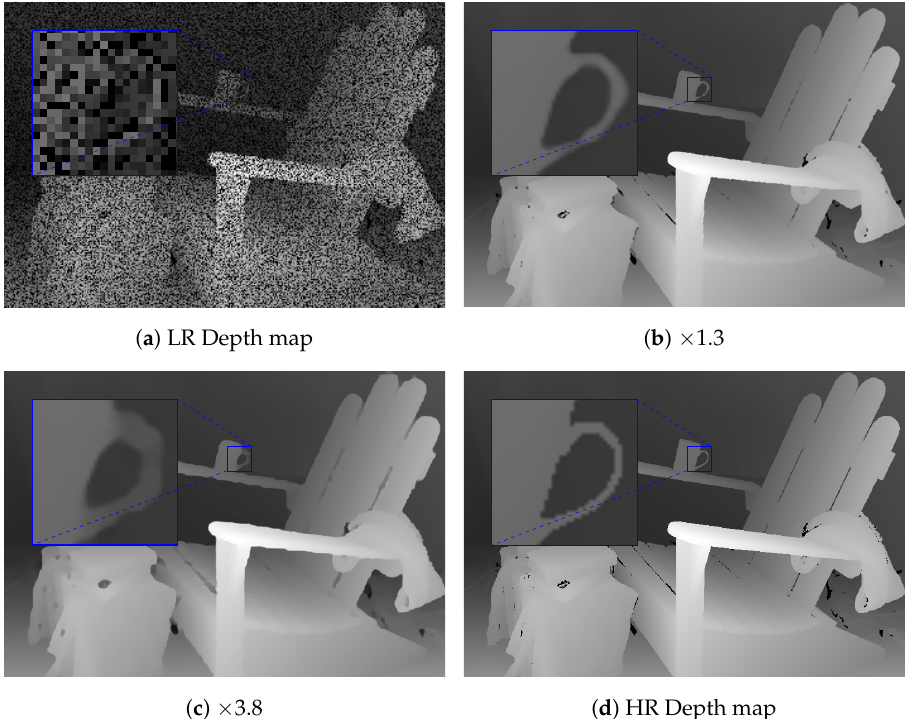
Figure 10. Visual comparison of DSR on the noisy Middlebury dataset [17,49–52] with different scale